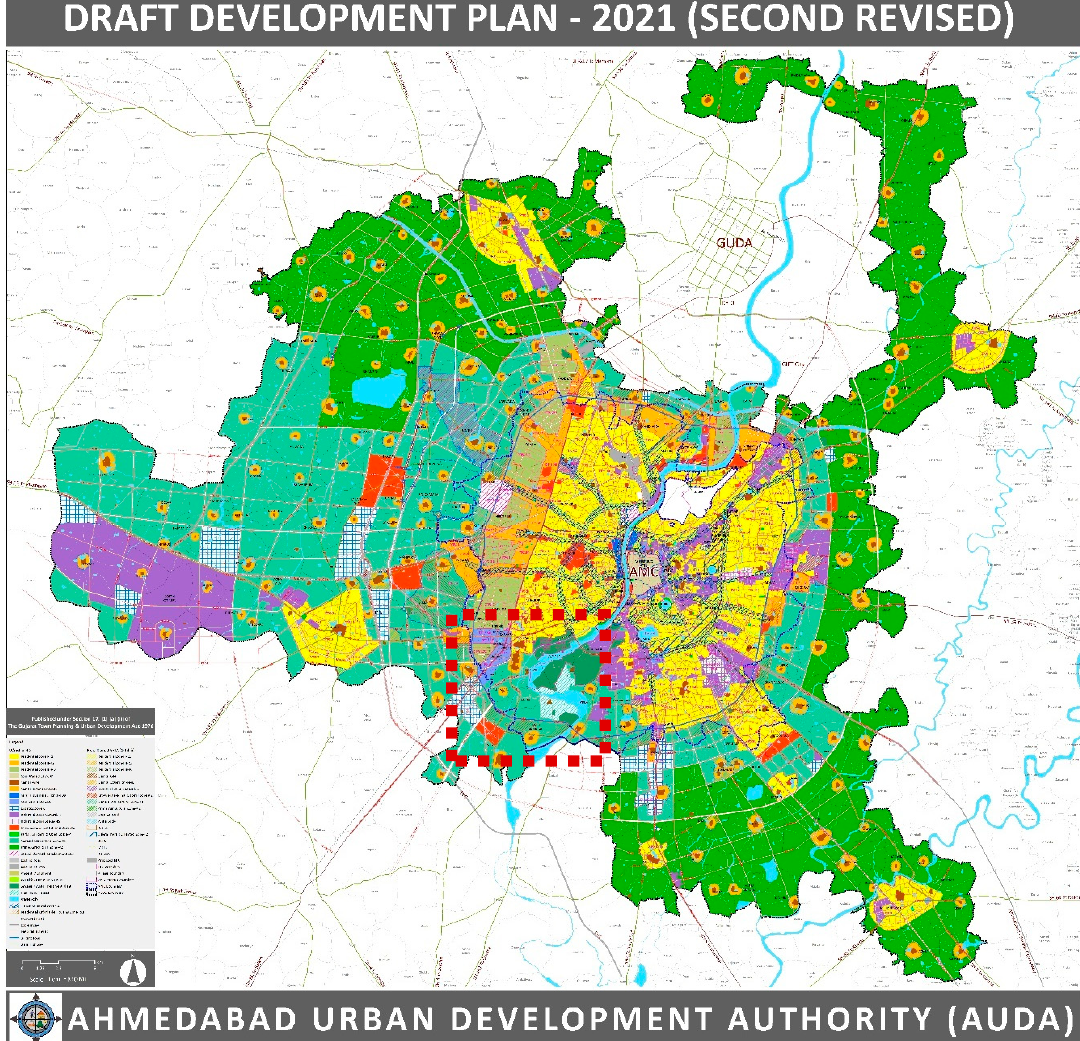
Figure 1. Development Plan, 2021, Ahmedabad Urban Development Authority: Source, AUDA. Accessible online at http://www.auda.org.in/RDP/.